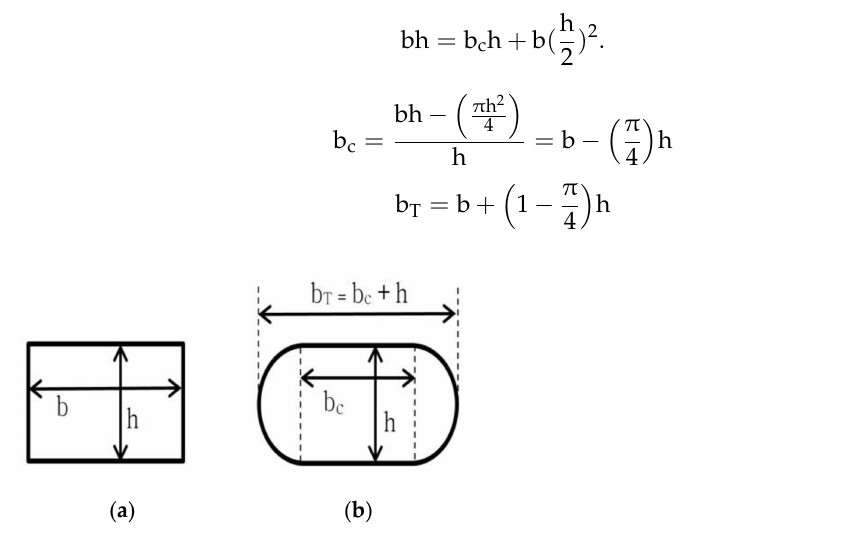
Figure 8. Photograph of the extrusion width for ( a ) the software and ( b ) the real 3D printing for a single wall. Table 2. Extruded line width according to piston feed